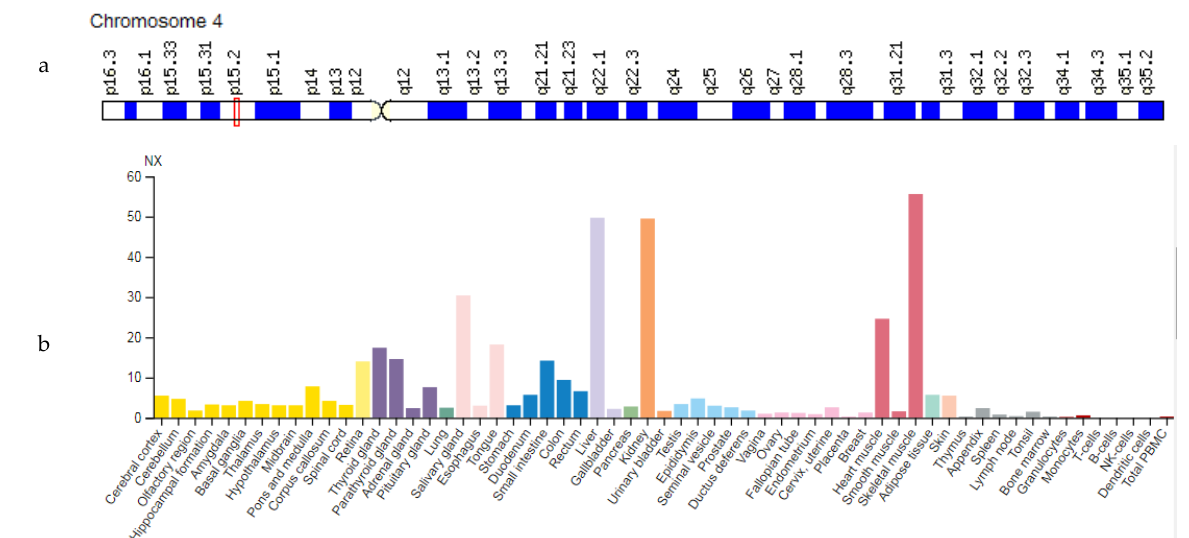
Figure 4. Location of the PPARGC1A gene ( a ) and tissue expression of the peroxisome proliferator-activated receptor gamma coactivator 1 Alpha ( b